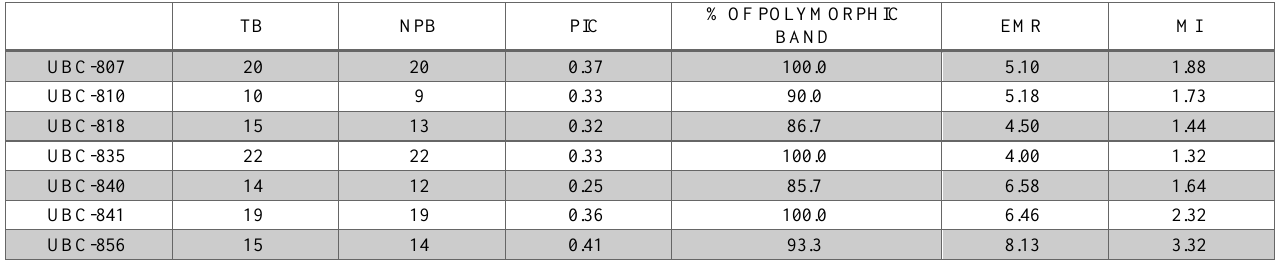
Table 4. Marker parameters calculated for each ISSR primer used with Ocimum basilicum